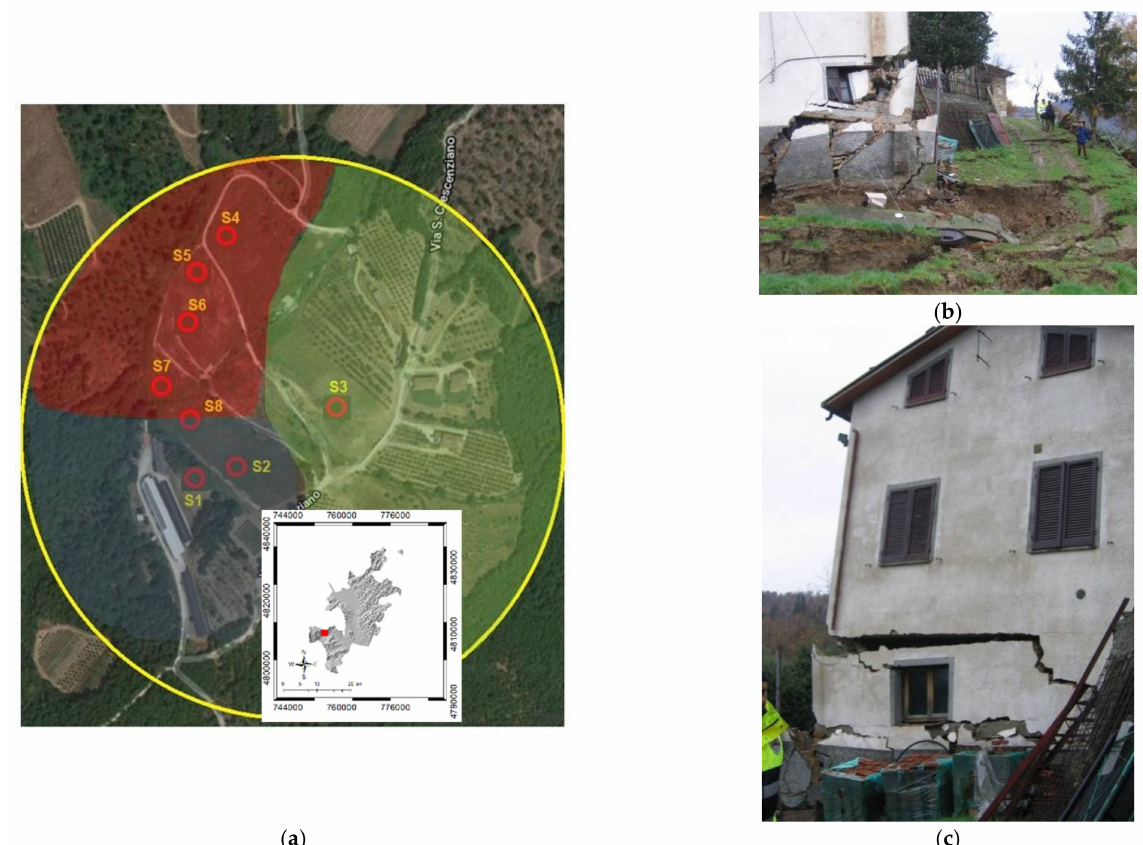
Figure 1. ( a ) Study area location, landslide area (yellow polygon), and position of geotechnical tests: S1–S8; ( b , c ) photos taken after the landslide event of 10 December